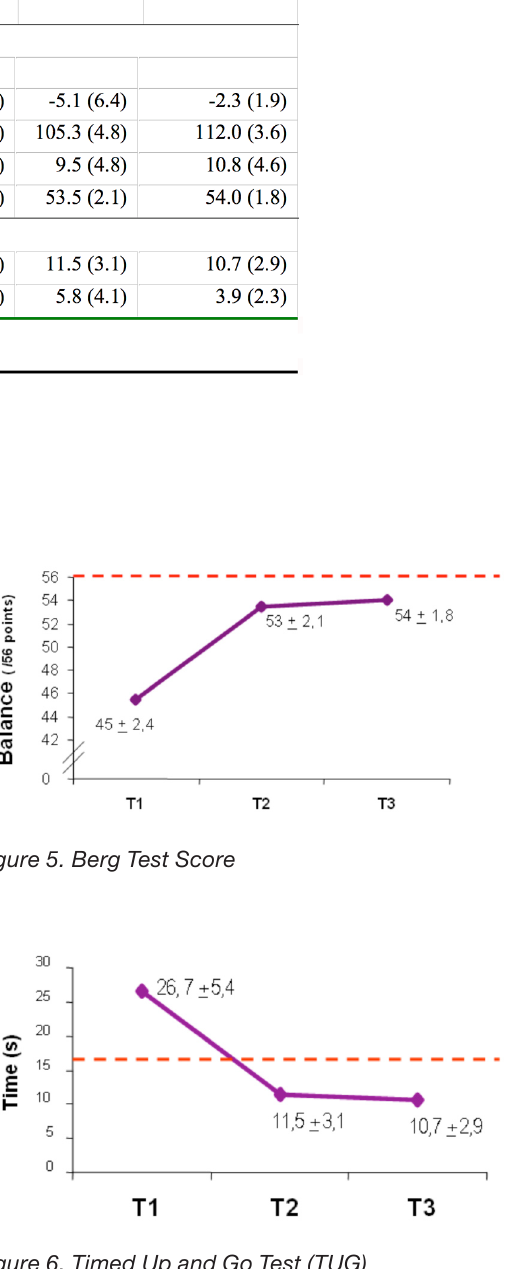
Figure 6. Timed Up and Go Test